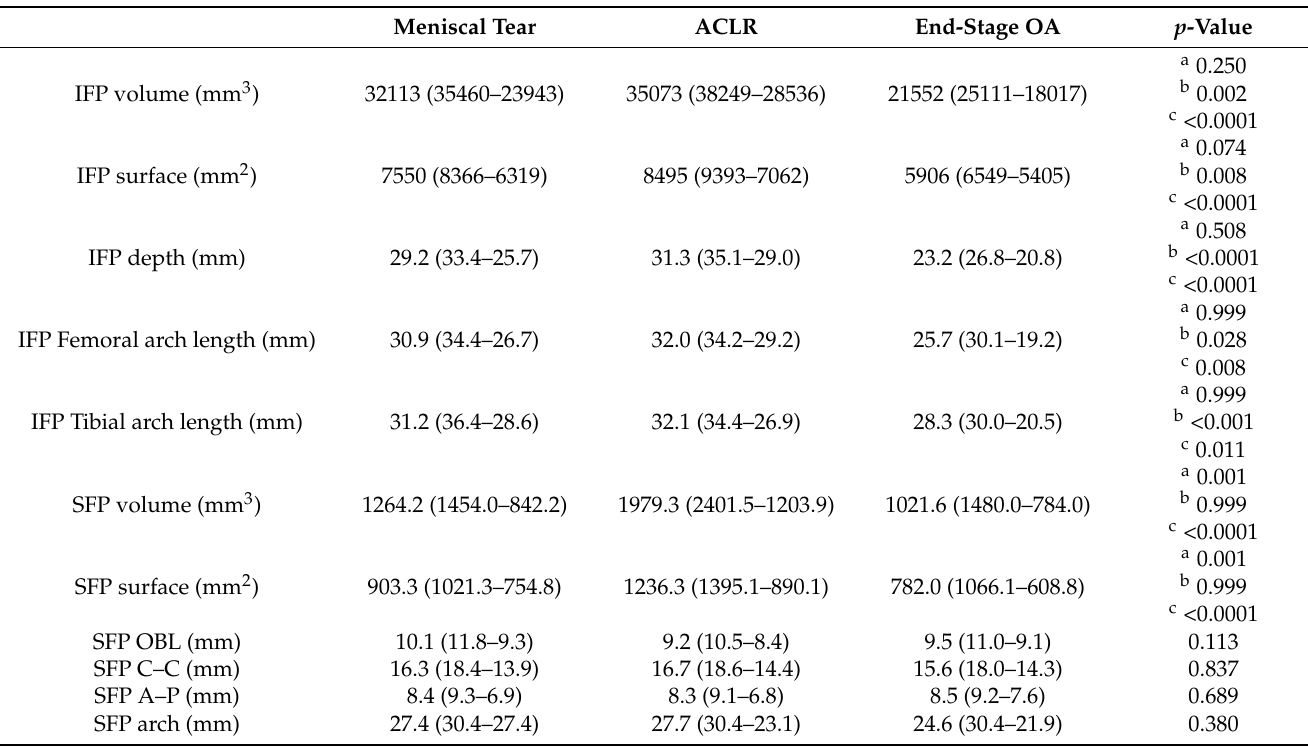
Figure 3. IFP morphometric characteristics in patients with meniscal tear, ACLR, and end-stage OA. ( a ) IFP volume, ( b ) IFP surface, ( c ) IFP depth, ( d ) IFP femoral arch, and ( e ) IFP tibial arch. Data are expressed as median and interquartile range. IFP: infrapatellar fat pad. ACLR: anterior ligament cruciate rupture. Table 2. IFP and SFP MR morphometric characteristics in patients with meniscal tear, ACLR, and end-stage